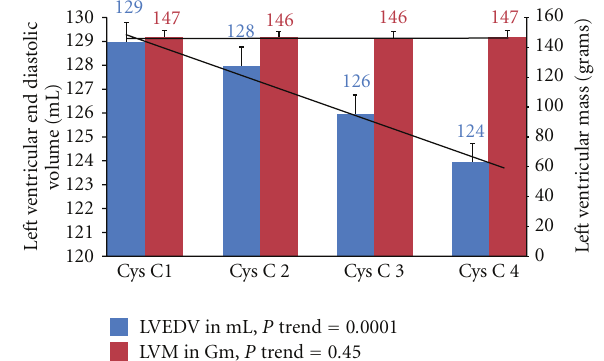
Figure 1: P trend in a fully adjusted model between Cystatin C quartiles and LVEDV and LVM in the MESA cohort (2000–2002). Cystatin C Quartiles 1: ≤ 0.76, Quartile 2: > 0.76 & ≤ 0.86, Quartile 3: > 0.86 & ≤ 0.98, Quartile 4: > 0.98; LVEDV, LV End Diastolic Volume; LVM, LV Mass; Model adjusted for age, gender, race/ethnicity, height, weight, diabetes, use of anti-diabetic medications, hyper- tension history, systolic blood pressure, total cholesterol, anti-lipid medications, and